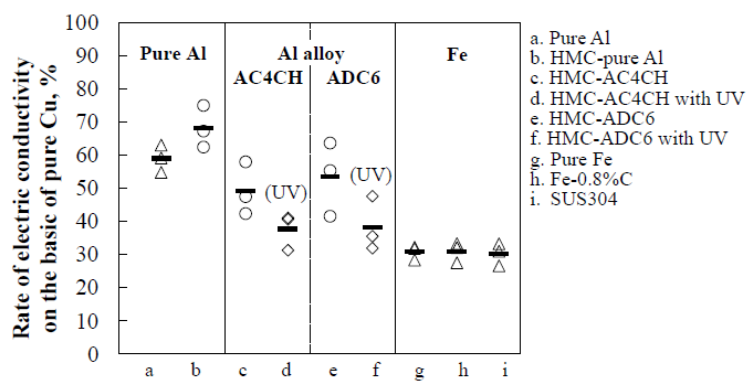
Figure 7. Rate of the electric conductivity for various materials on the basis of that for pure copper (HMC: heated mold continuous